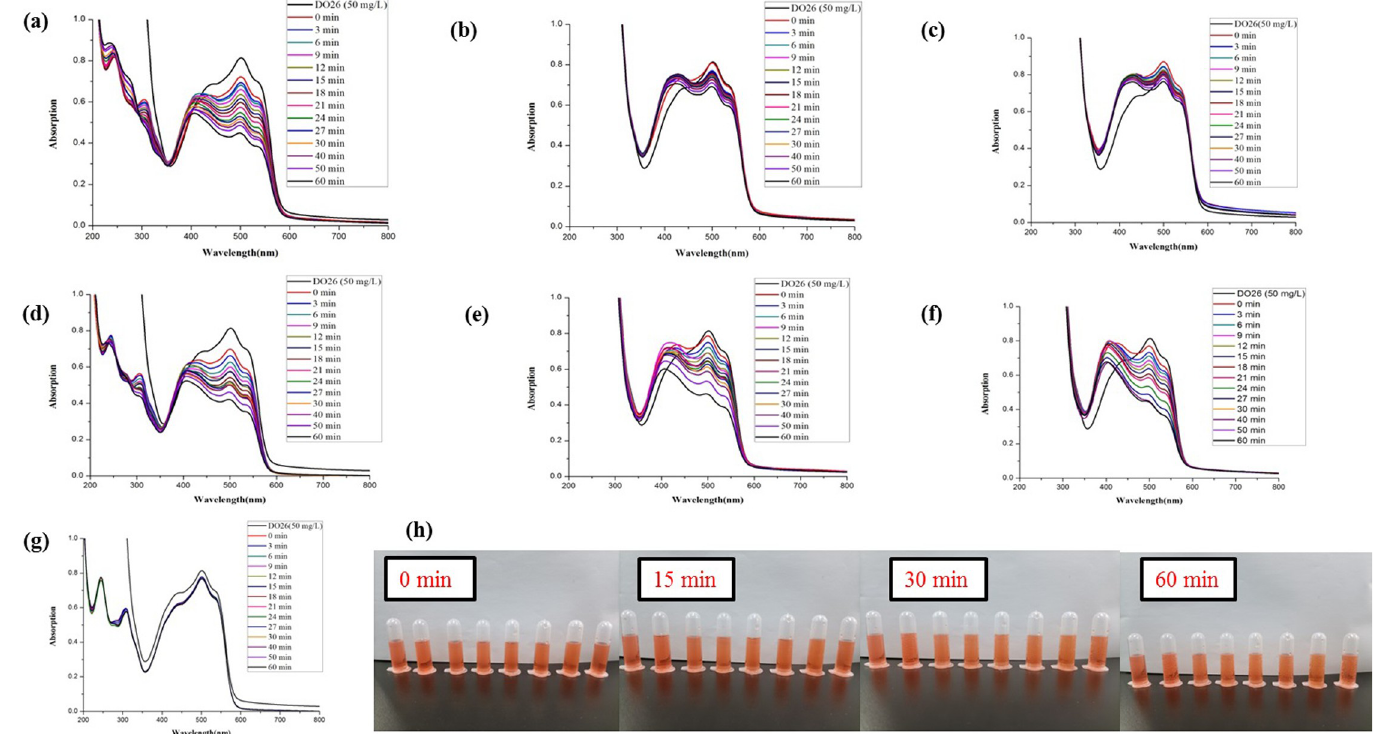
Fig 10. Comparison of the reductive degradation of Direct Orange 26 using different Z . officinale AgNPs synthesized from dry ginger extracts: (a) unpeeled dry ginger water extract AgNPs; (b) peeled dry ginger water extract AgNPs; (c) dry ginger peel water extract AgNPs; (d) unpeeled dry ginger ethanol extract AgNPs; (e) peeled dry ginger ethanol extract AgNPs; (f) dry ginger peel ethanol extract AgNPs; (g) CK; (h) The solution appearance comparison of mixtures Z . officinale AgNPs and DO26 after reaction for 0, 15, 30 and 60 min. The solutions from left to right are DO26 (50 mg/L), CK, unpeeled dry ginger water extract AgNPs, peeled dry ginger water extract